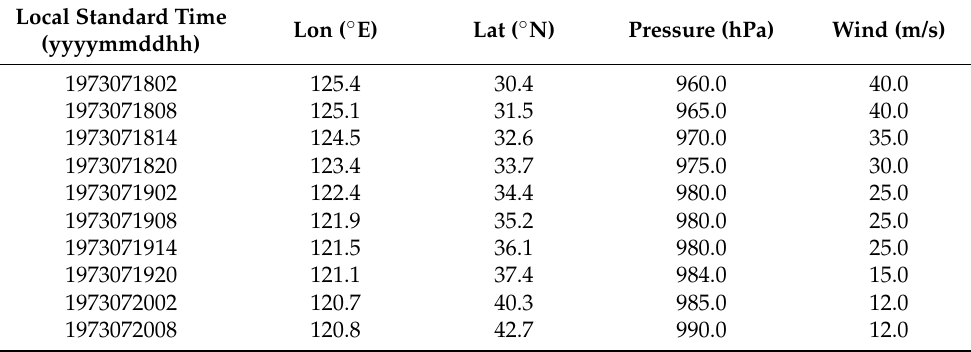
Table 2. Best track, central pressure, and maximum wind speed for Typhoon 7303. Local Standard